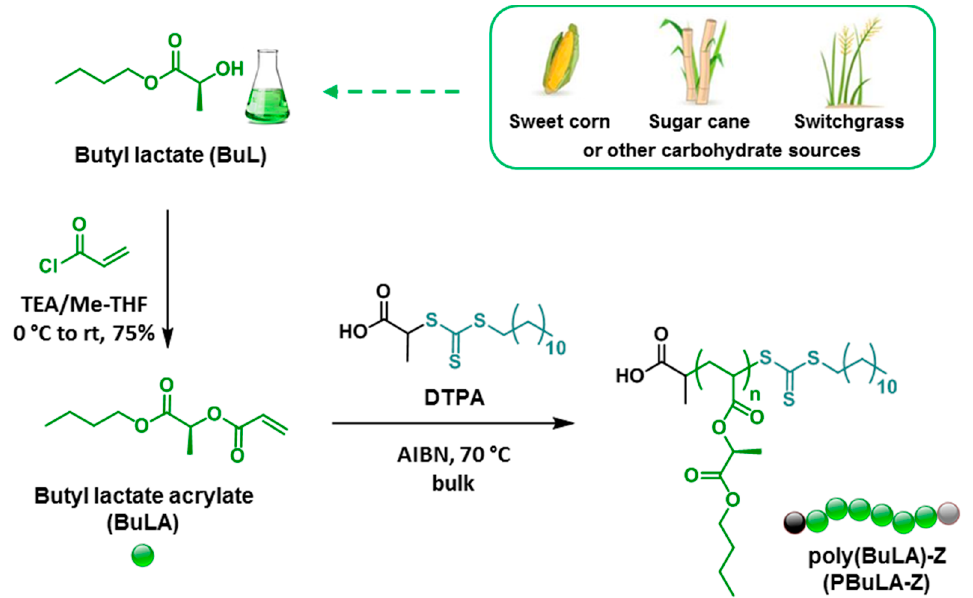
Figure 1. Synthesis of BuLA from biorenewable BuL solvent and their bulk reversible addition– fragmentation chain transfer (RAFT) polymerization using a monofunctional chain transfer agent (CTA), namely 2-(dodecylthiocarbonothioylthio)propionic acid (DTPA) to yield PBuLA-Z.